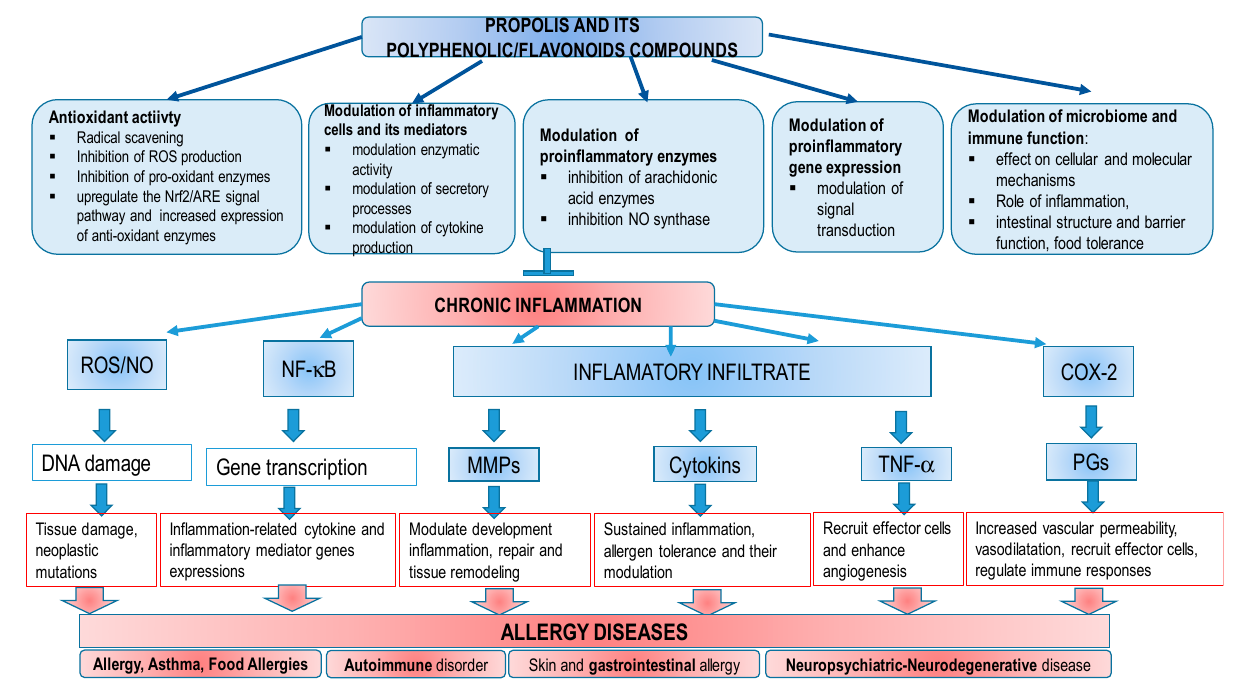
Figure 4. Inflammatory pathways as potential targets for propolis and related flavonoids in allergy treatment. Propolis and its components, with their antioxidant and anti-inflammatory abilities, modulate the activity of inflammatory cells, enzymes and pro-inflammatory genes as well as gut microbiome and immune function. By blocking the accumulation of inflammatory cells, such as phagocytic cells, mast cells and endothelial cells, they reduce the production of important inflammatory mediators including proteins, peptides, glycoproteins, cytokines, arachidonic acid metabolites (prostaglandins and leukotrienes), nitric oxide, and oxygen free radicals. ROS/NO produced by inflammatory and endothelial cells can lead to tissue damage as well as activation of NF- κ B, which regulates many aspects of innate and adaptive immune functions and serves as a key mediator of inflammatory reactions. Note: ROS, Reactive oxygen species; NO, Nitric oxide; NF- κ B, Nuclear factor kappa-light-chain-enhancer of activated B cells; COX-2, Cyclo-oxygenase-2; MMPs,